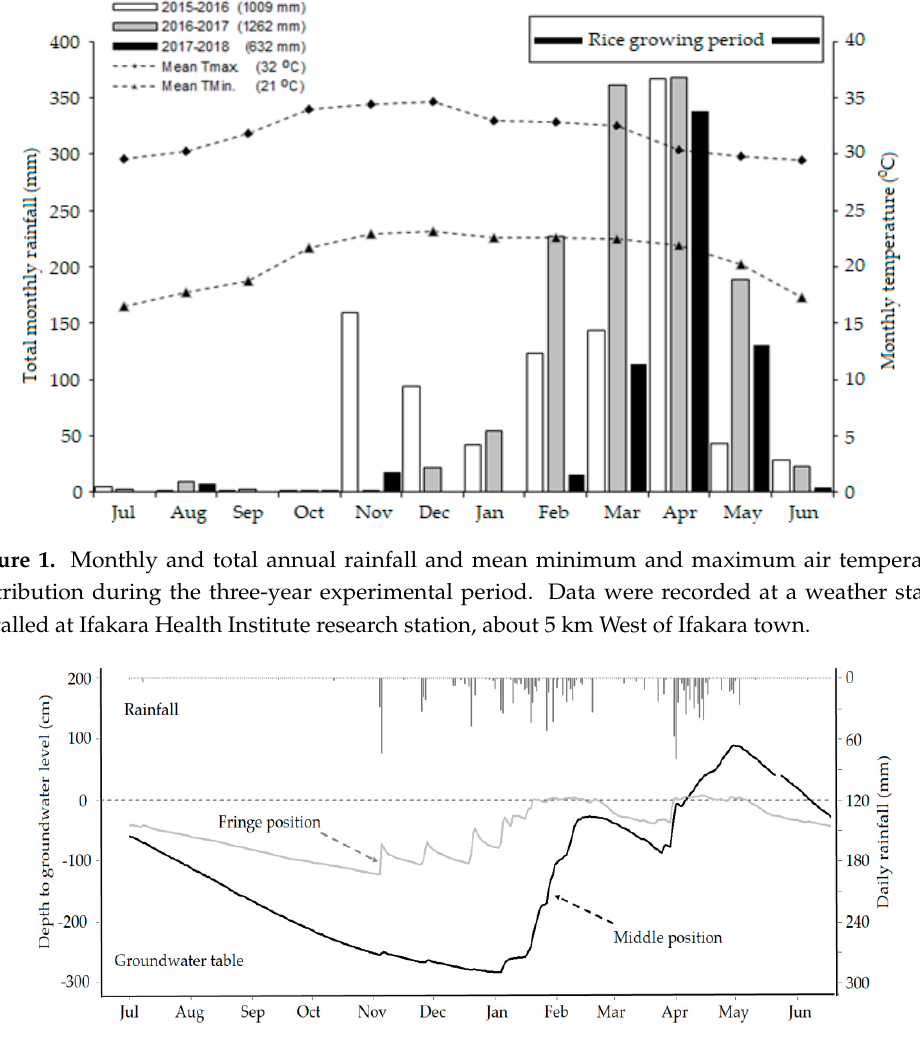
Figure 2. Depth to ground water level dynamics resulting from the surface water and groundwater interaction during dry, short- and long-rain season for the fringe and middle positions of the Kilombero floodplain, Tanzania from July 2015 to June 2016. Adapted from Gabiri et al. [33].